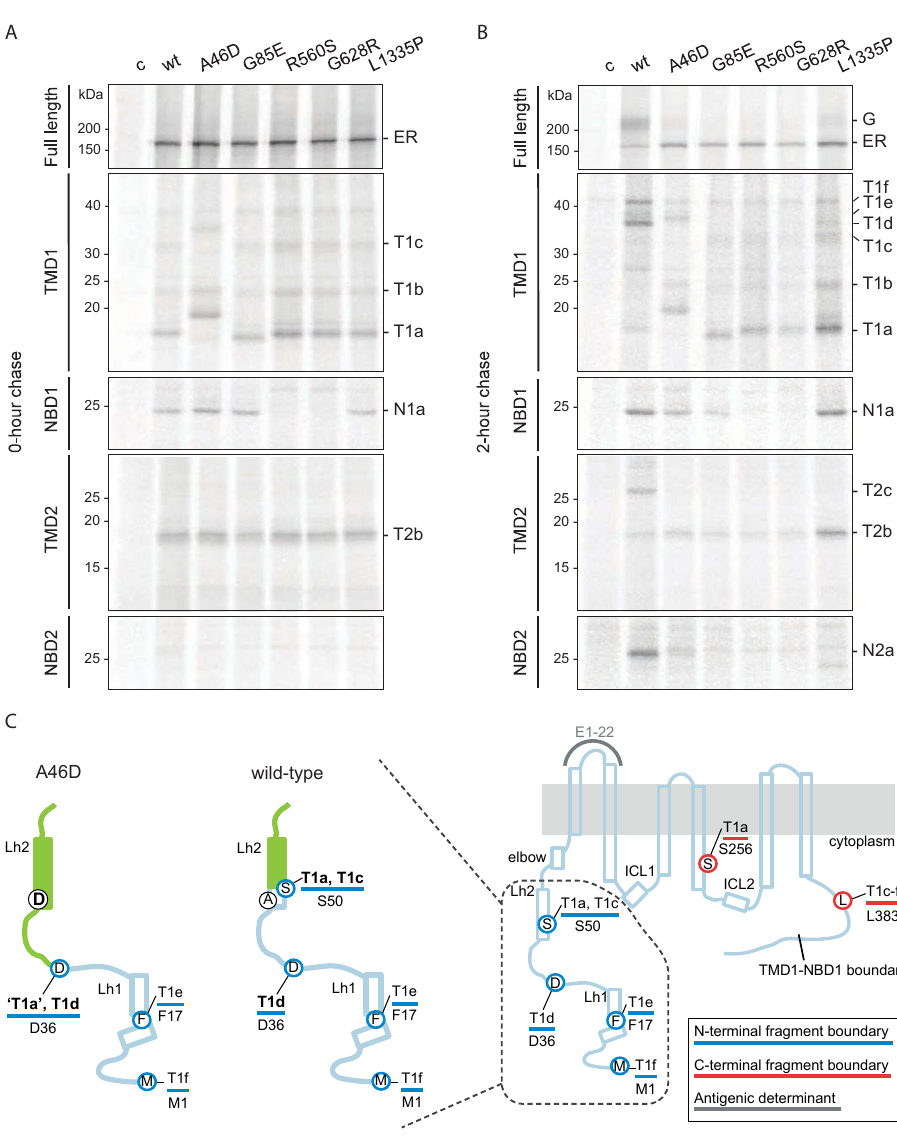
Figure 2. Hypo-responder mutants show defects in molecular folding ( A ) HEK293T-cells expressing wild-type or mutant CFTR were radiolabeled for 15 min. Cells were lysed with 1% Triton X-100 and the detergent cell lysates were subjected to 0 (top panel) or 25 µ g/mL proteinase-K digestion for 15 min. Non-proteolyzed CFTR was immunoprecipitated using MrPink (top panel) and domain- specific fragments (lower panels) with E1-22 (TMD1), MrPink (NBD1), TMD2C (TMD2), or 596 (NBD2). Undigested CFTR was analyzed on 7.5% SDS-PA gel and digested CFTR on 12% SDS-PA gel. Representative gel of at least three repeats. Lane profiles of wild-type and G85E T1a-c are shown in Figure S3B. ( B ) As in ( A ), but radiolabeled CFTR was chased for 2 h. T1a–f, protease-resistant TMD1-specific fragments; N1a, protease-resistant NBD1-specific fragment; T2a–c, protease-resistant TMD2-specific fragments; N2a, protease-resistant NBD2-specific fragment. ( C ) Cartoon highlighting the A46D-induced changes in the N-termini of proteolytic TMD1 fragments. Wild-type TMD1 fragments are T1a–f. The A46D-induced aberrant fragments result from protection of the S49 region and N-terminal extension of TMD1 fragments T1a and T1c (green-filled): T1a becomes a shifted, larger ‘T1a’, and T1c turns into T1d. Alpha helices are depicted as rectangles; grey line, antigenic epitope E1-22; blue lines and blue-circled residues, N-terminal boundaries of fragments; red lines and red-circled residues, C-terminal boundaries of fragments; Lh1, lasso helix 1; Lh2, lasso helix 2; elbow, N-terminal elbow